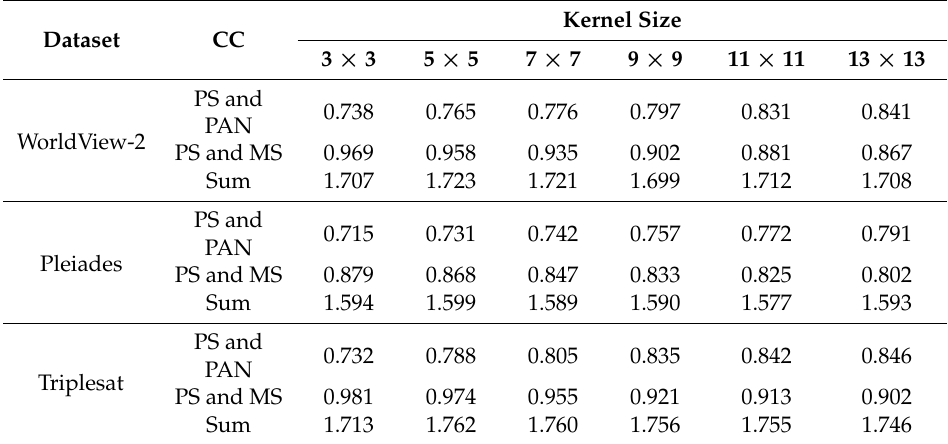
Table 5. Impact of smoothing filer kernel size in SFIM on three